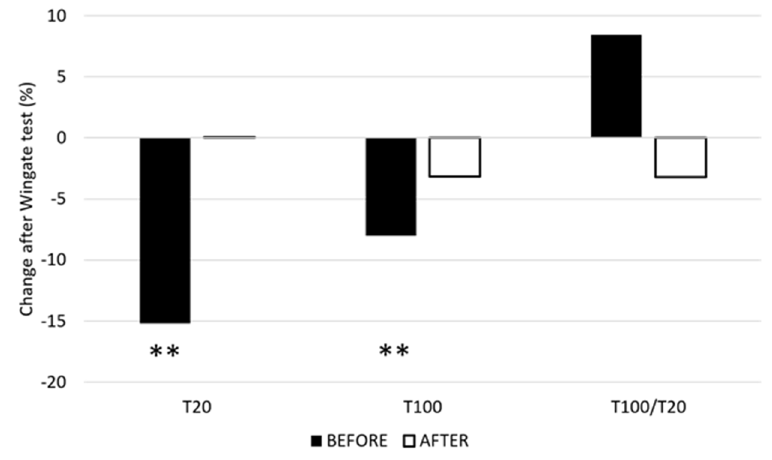
Figure 1. Relative mean changes of T20 and T100 before and after the training. T20—torque during 20 Hz ES, T100—torque during 100 Hz ES, and T100/20—ratio between T100 and T20. **— p ≤ 0.01 .